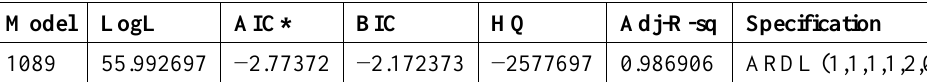
Table 3. Growth in Nigeria: Results of Model Lag Selection for ARDL,